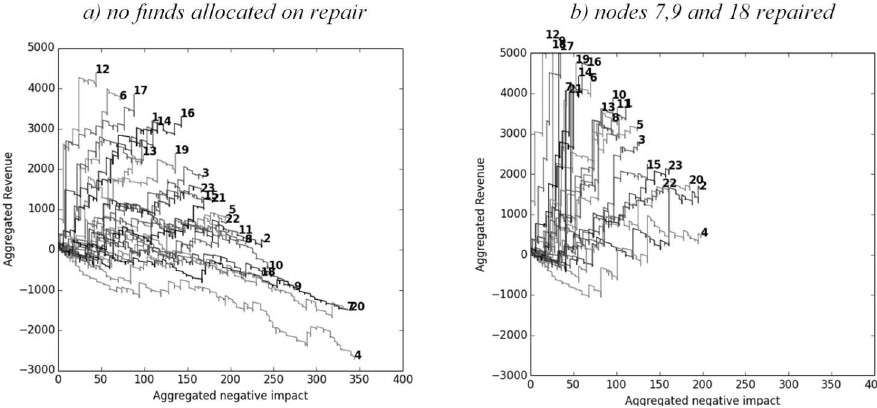
Figure 8. The network effect on of repairing nodes – performance of other nodes (e.g. 4 has